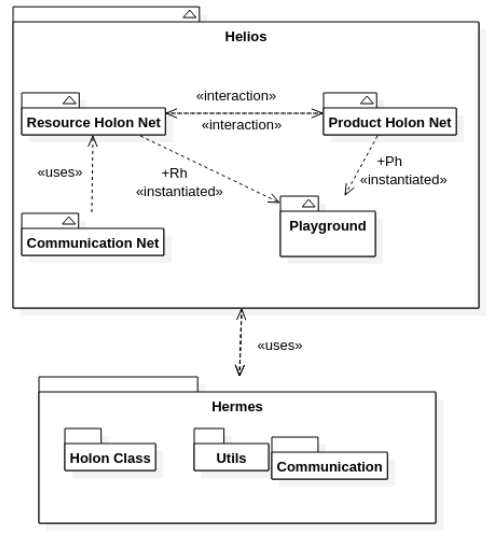
Figure 8. Representation of the structure of the PRESIB